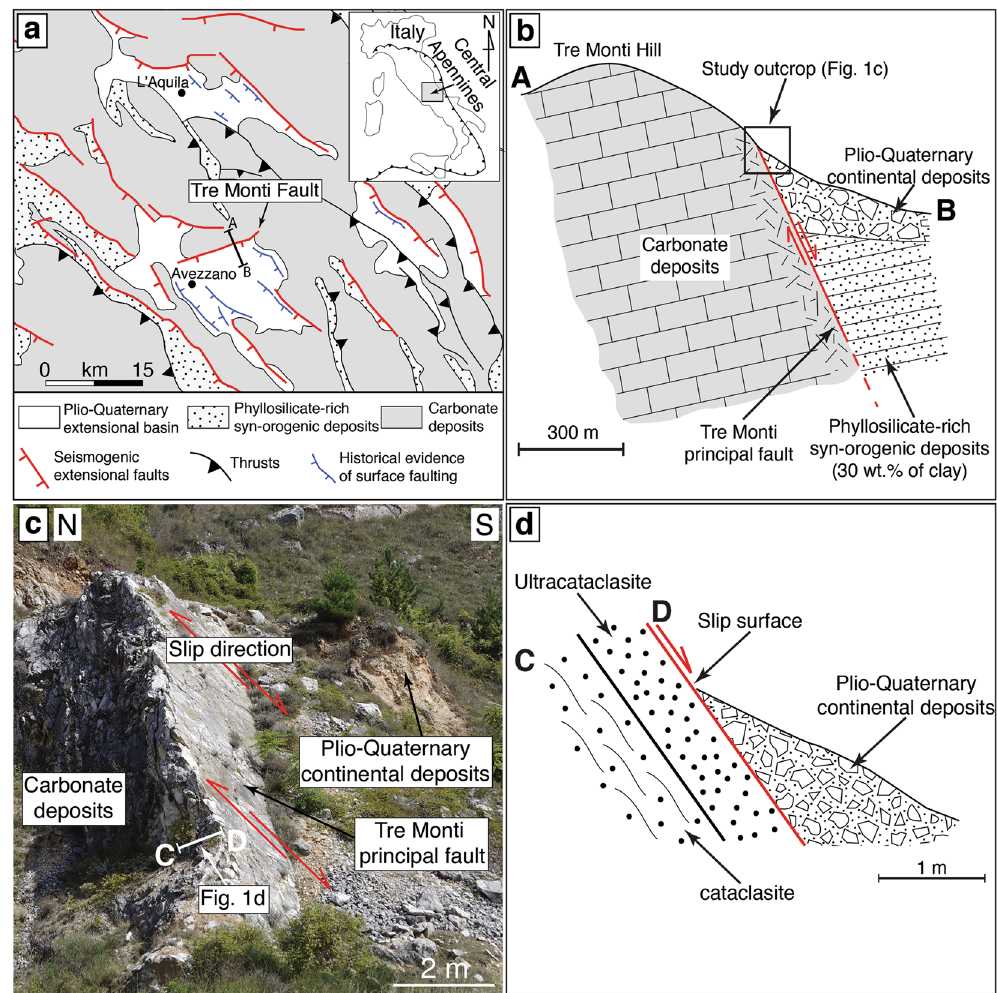
Figure 1. Geological setting. ( a ) Geological setting of the Tre Monti Fault and evidence of surface faulting from historical earthquakes in the central Apennines, Italy. Geological map and base map has been drawn using Adobe Illustrator CS5. (b ) Simplified geological cross-section through the Tre Monti Fault. Cross-section trace in ( a ). Cross-section has been drawn using Adobe Illustrator CS5. (c) The study outcrop of the Tre Monti principal fault (Latitude 42°04 ′ 34 ″ N, Longitude 13°29 ′ 58 ″ E). (d) Simplified structural cross-section through the Tre Monti principal fault showing the ultracataclasite above the foliated cataclasite. Cross-section has been drawn using Adobe Illustrator